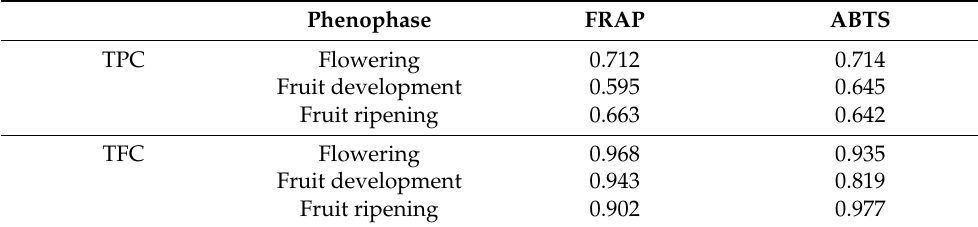
Table 5. Pearson correlations between phenolic compounds and antioxidant activity in raspberry leaves. Phenophase FRAP ABTS TPC Flowering 0.712 0.714 Fruit development 0.595 0.645 Fruit ripening 0.663